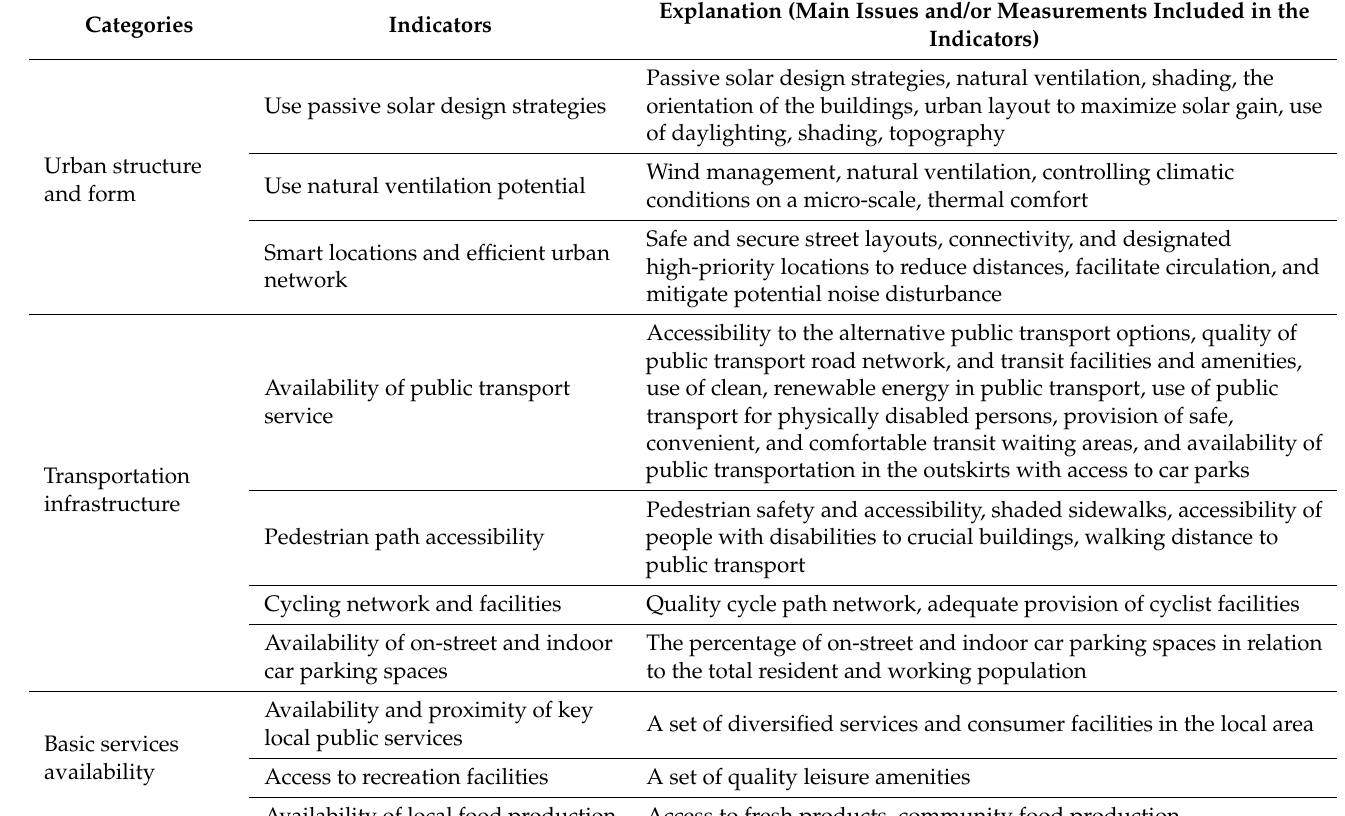
Table 1. Redistributing indicators according to sustainability